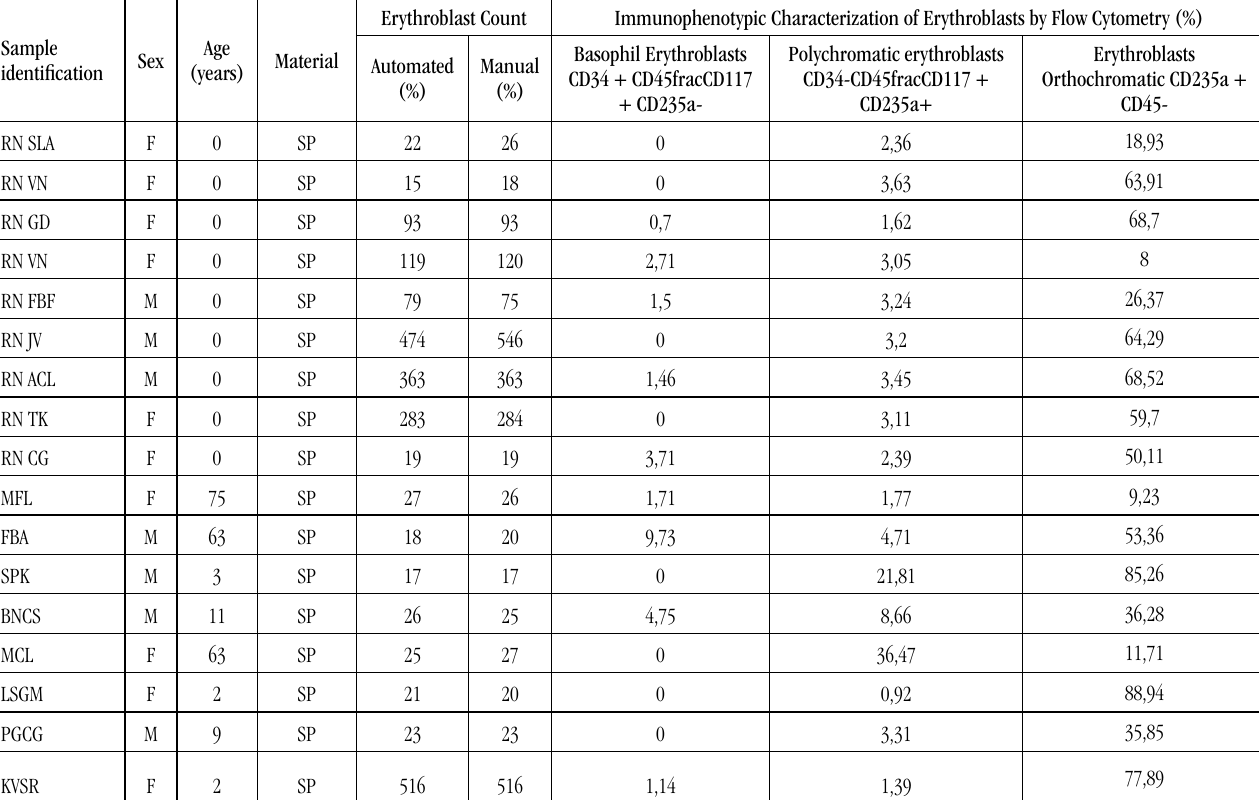
TABLE 1- Analysis of counts, manual and automated, and immunophenotypic characterization of erythroblasts in peripheral blood samples from patients from the routine of the Dr Paulo C Azevedo Clinical Pathology Laboratory, from June 2019 to December 2020 Sample identification